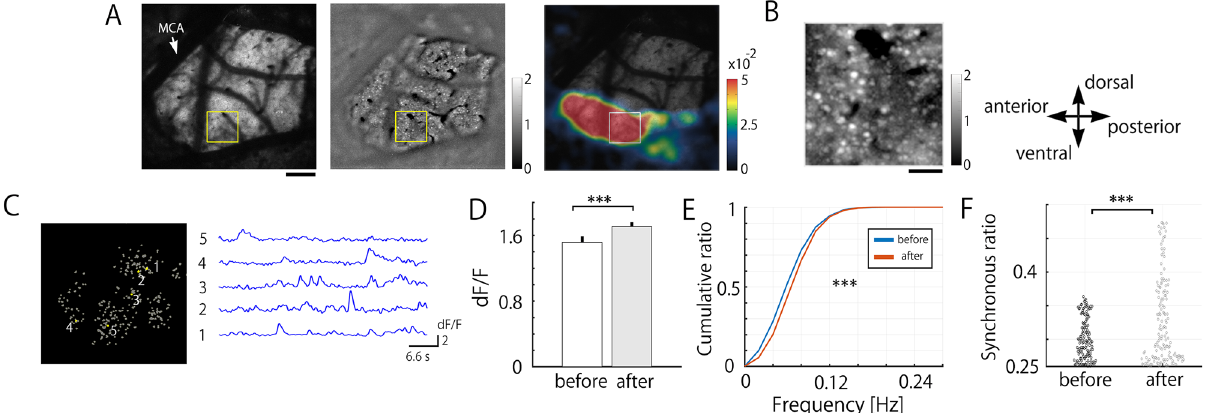
Figure 3. Two-photon calcium imaging of IC spontaneous neuronal activities in the session before and after PDL stimulation. ( A ) Detection of the IC region responding to PDL stimulation. Left , a vascular pattern of the cortical surface imaged by two-photon microscopy. Scale bar 200 µm. Middle , The time-stack average of spontaneous calcium activities in the same field as on the left. Each small bright dot indicates GCaMP6s- expressing neurons. Right , the merged image of the vascular pattern (left) and wide-field calcium imaging responding to PDL stimulation. ( B ) The enlarged image of the time-stack spontaneous calcium image shown in ( A , middle ). Scale bar 50 µm. ( C ) Masks of the regions of interest identified by the constrained nonnegative matrix factorization algorithm ( left ) and 5 representative spontaneous calcium signals ( right ) highlighted by yellow on the left. ( D ) The amplitude of spontaneous calcium signals in the session after PDL stimulation was larger than that before PDL stimulation (Mann–Whitney U test; *** p < 0.001). ( E ) A cumulative plot of the frequency of spontaneous calcium activities in the session before and after PDL stimulation (Kolmogorov– Smirnov test; *** p < 0.001). ( F ) PDL stimulation augmented spontaneous synchronous calcium activities across the neuronal population (Mann–Whitney U test; *** p <